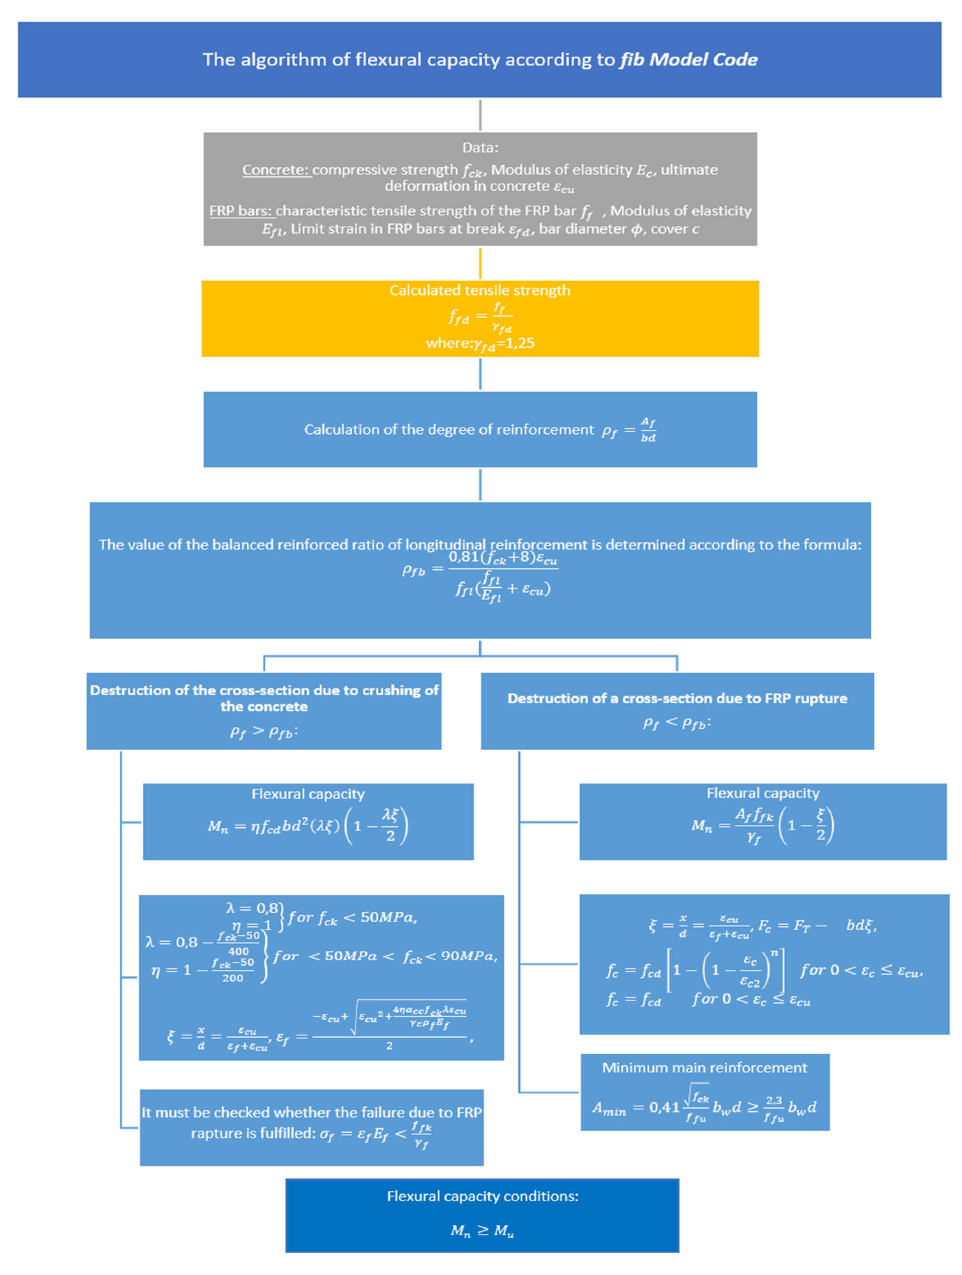
Figure 9. The algorithm of flexural capacity pursuant to the fib Model Code guidelines.